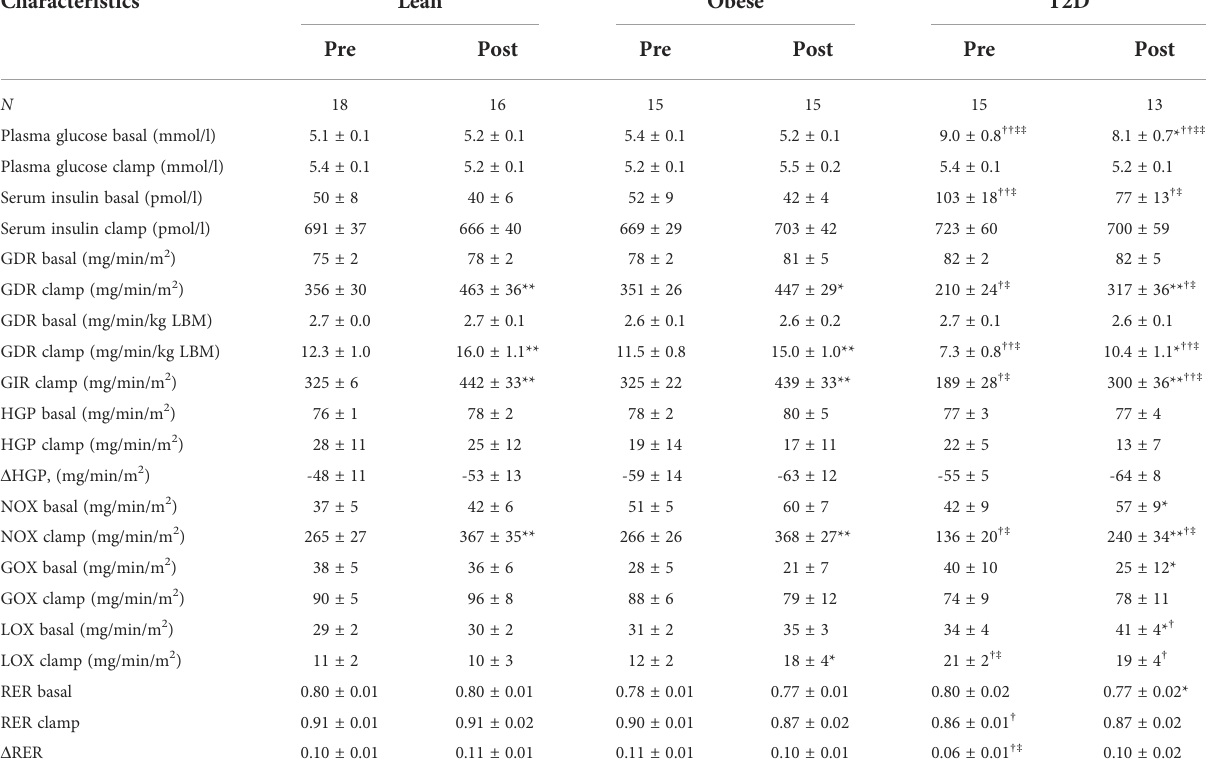
TABLE 2 Metabolic characteristics during clamp, pre- and post-training.